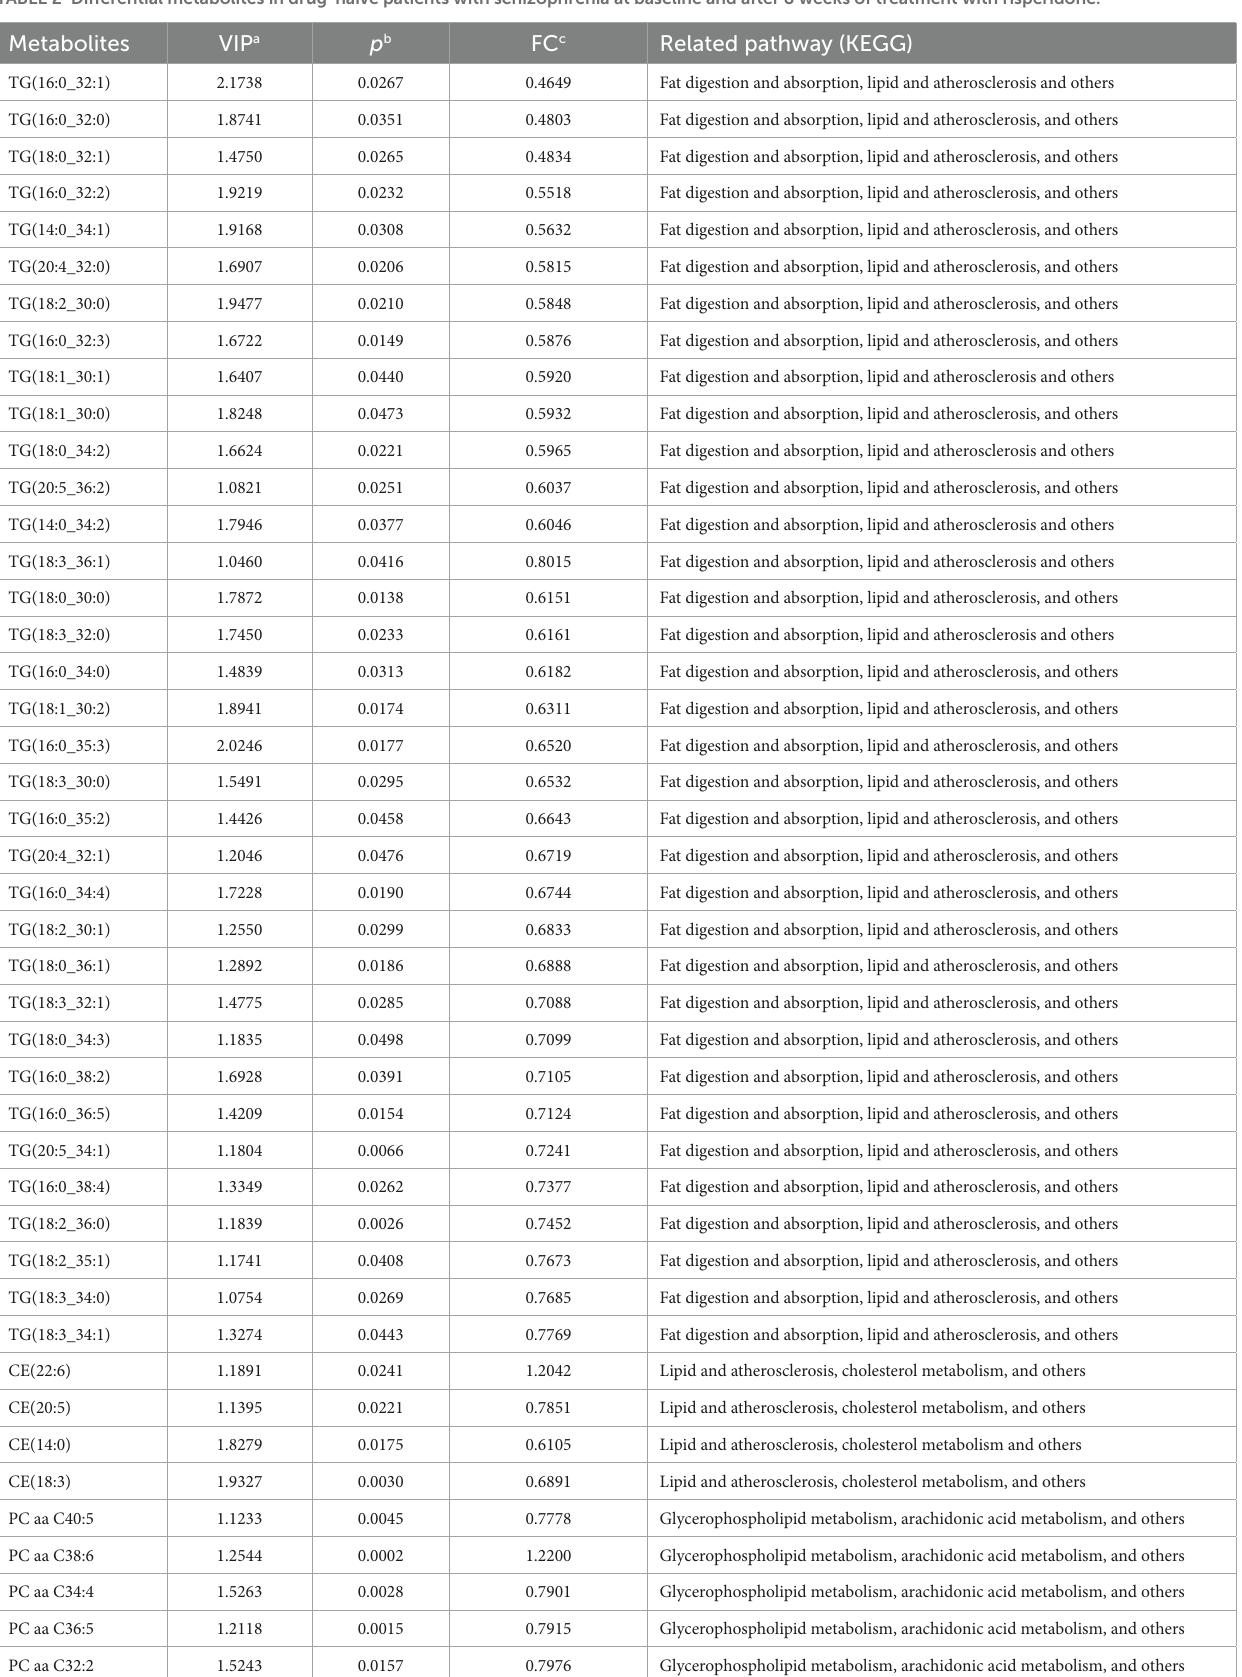
TABLE 2 Differential metabolites in drug-naive patients with schizophrenia at baseline and after 8 weeks of treatment with risperidone. Metabolites VIP a p b FC c Related pathway